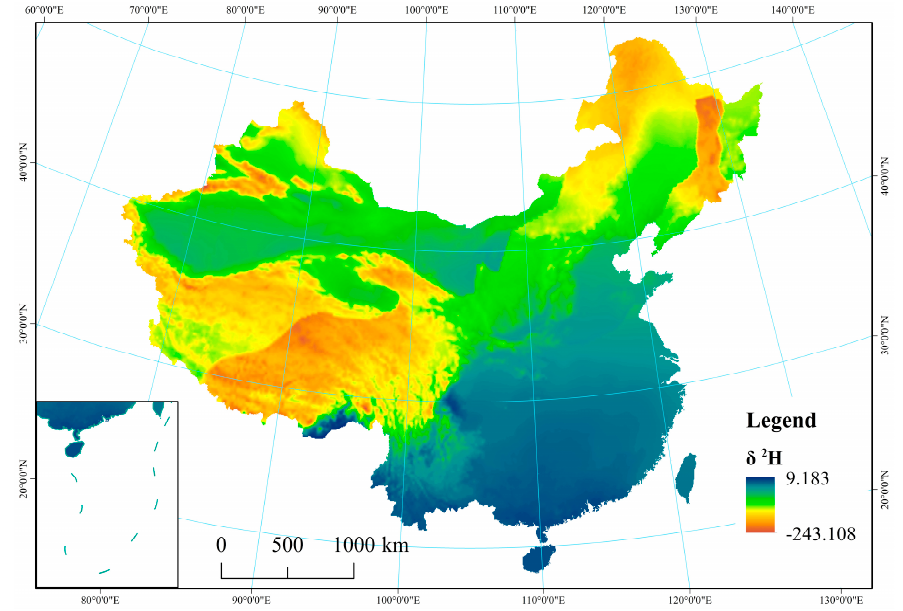
Figure A2. Spatial distribution of δ 2 H in precipitation across China.